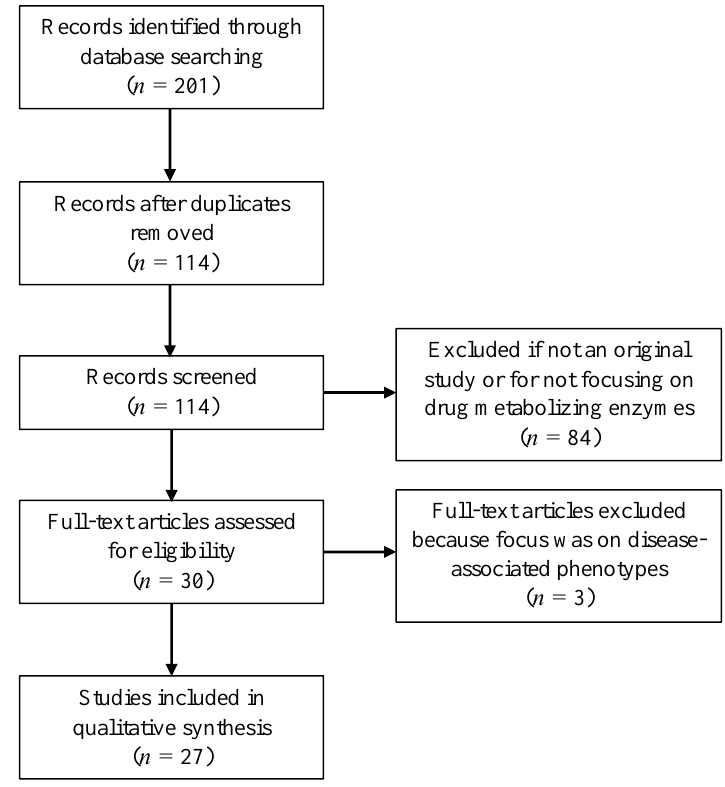
Figure 1. Flow diagram depicting the number of records identified, included and excluded in this review.